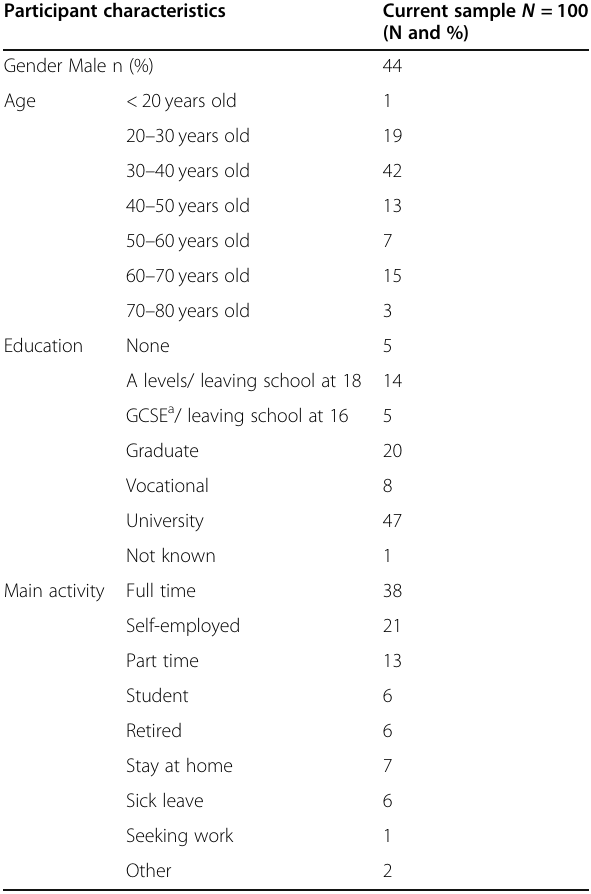
Table 1 Socio-demographic profile of the general public